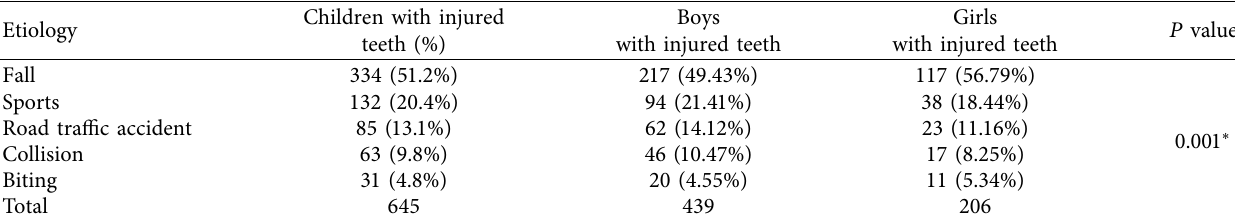
Table 4: Te distribution and percentage of children with traumatized anterior teeth according to the place of occurrence of trauma.